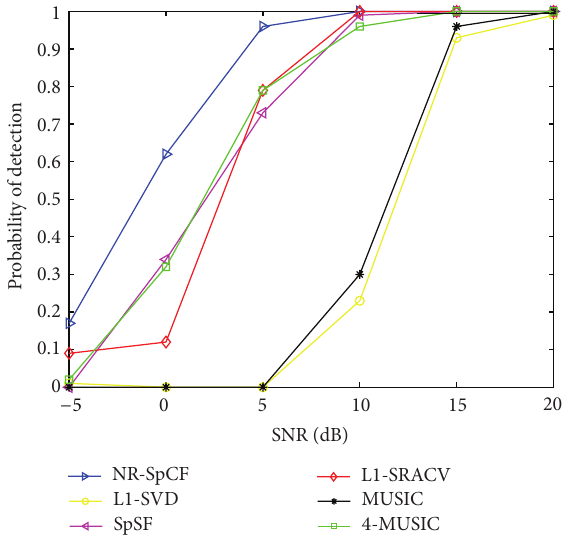
Figure 6: The resolution ability versus SNR for the six methods. 𝑀 = 6 , and 𝑇 = 1000 .